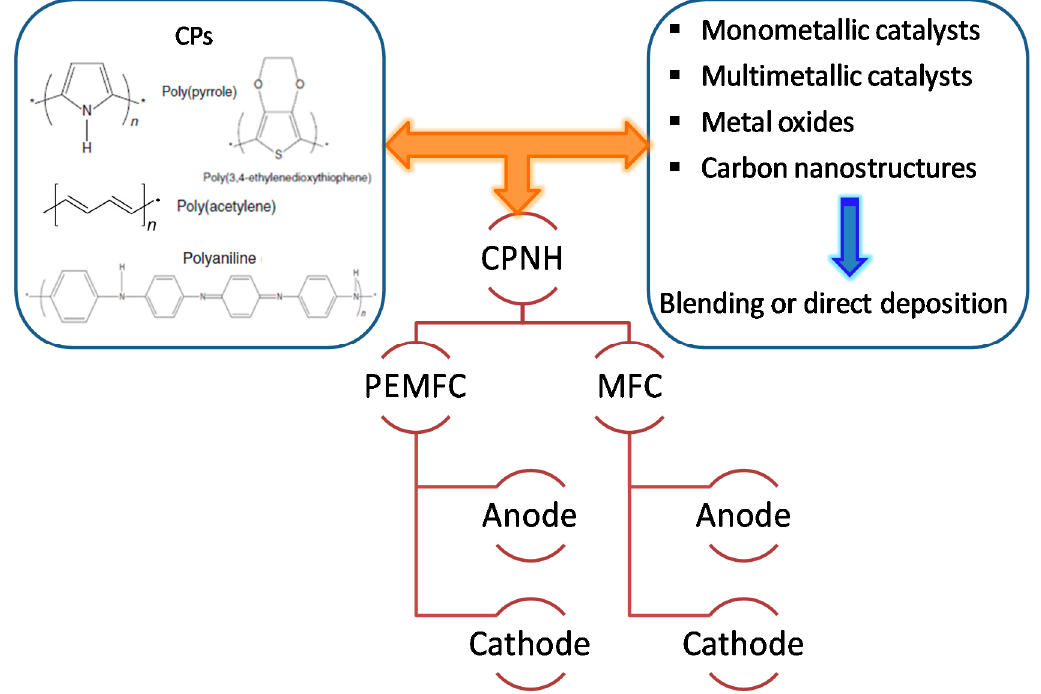
Figure 1. The active components of conducting polymer-based nanohybrids (CPNHs) in fuel cell materials.